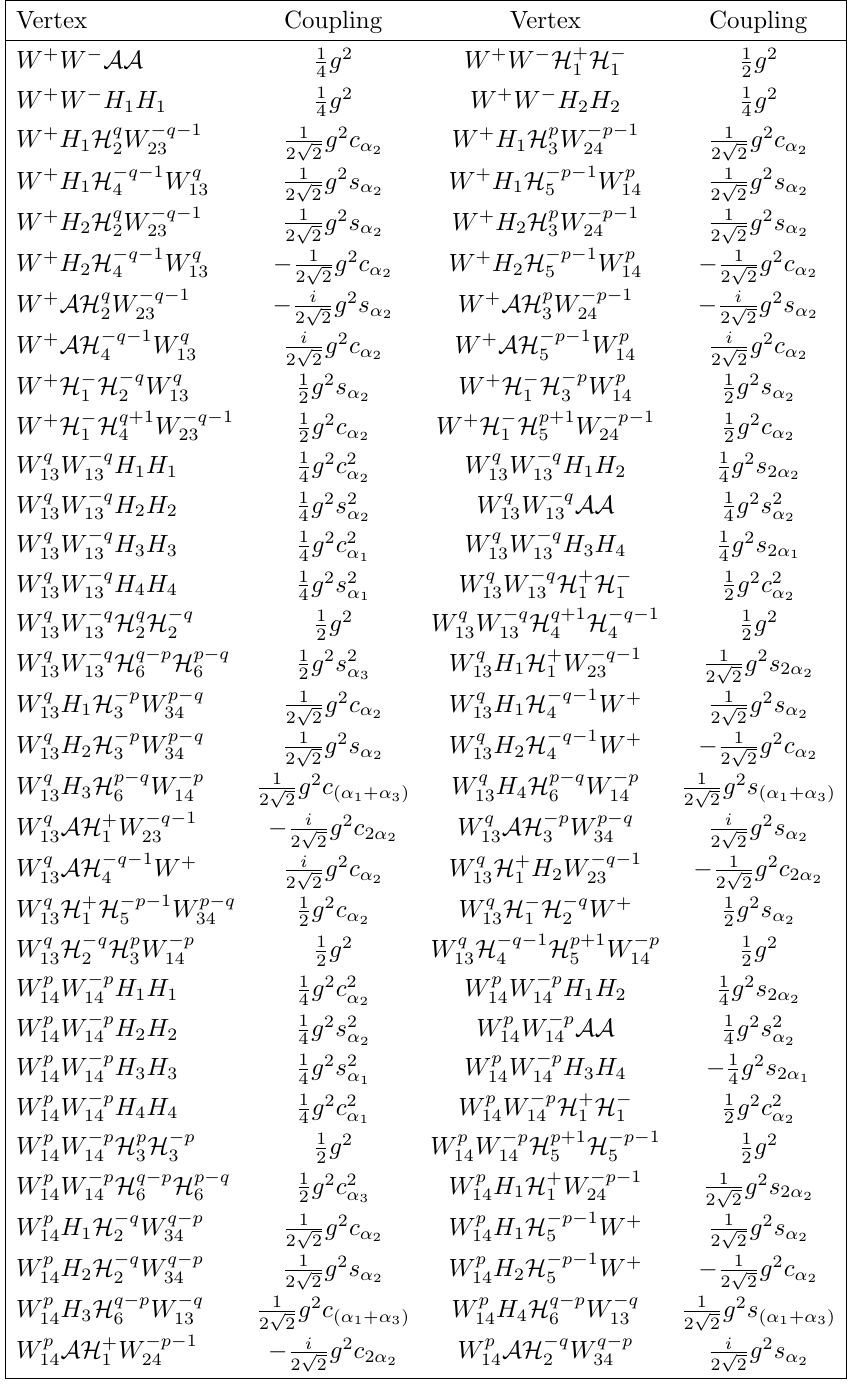
Table 12 . The interactions of two charged gauge bosons with two scalars (table continued).